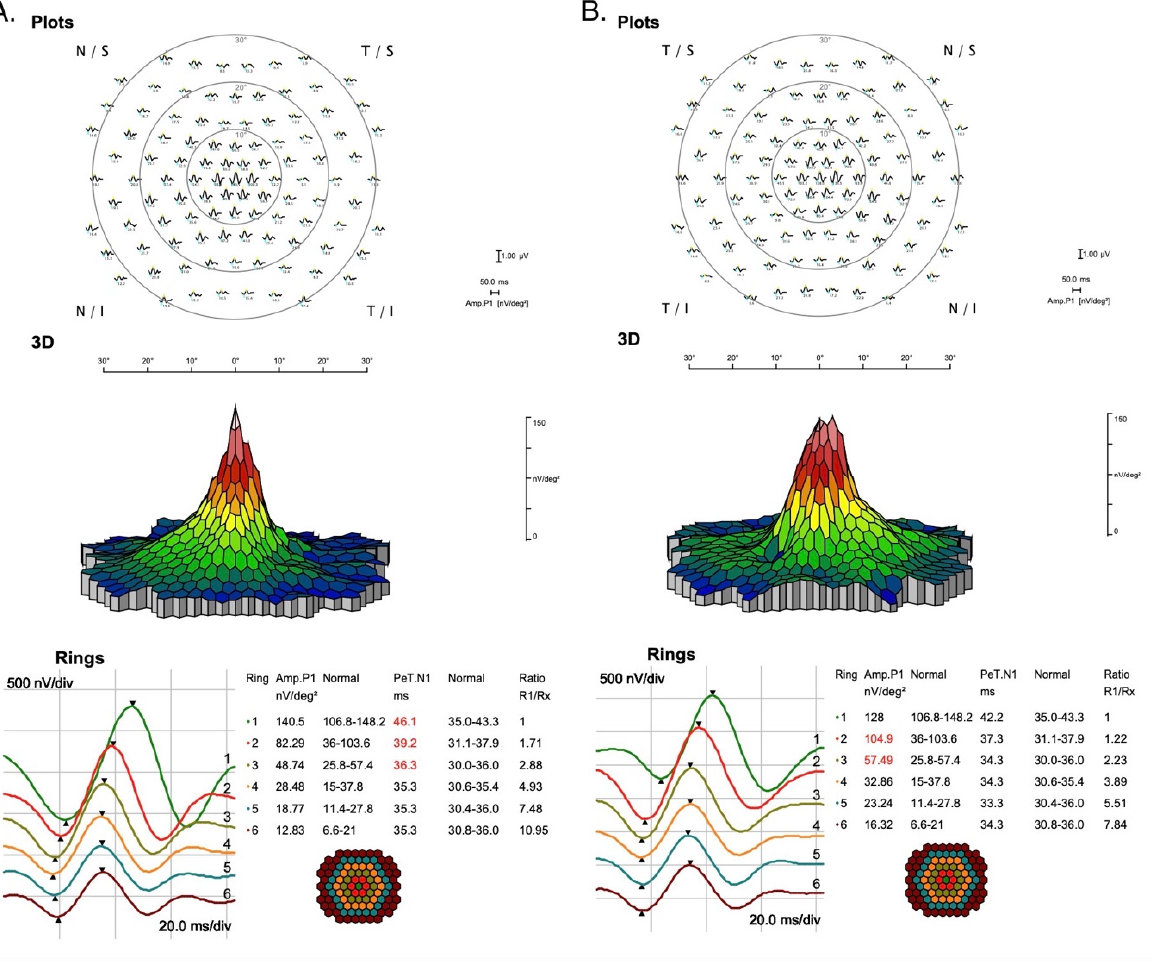
Figure 5. Fluorescein angiography imaging, right eye ( A ) and left eye ( B ), respectively. Multifocal electroretinography (mfERG) was normal in the left eye but abnormal in the right eye. In addition, the increase of implicit time of P1—wave from rings R1-R3 in- dicates slight macular cone photoreceptors / bipolars dysfunction secondary to RPE de- generation in this region [Figure 6].